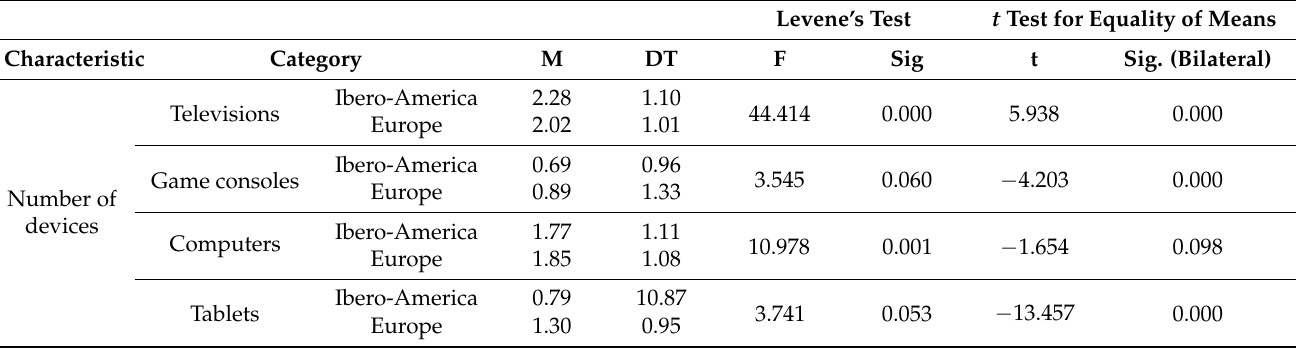
Table 2. Number of technological devices depending on the area of